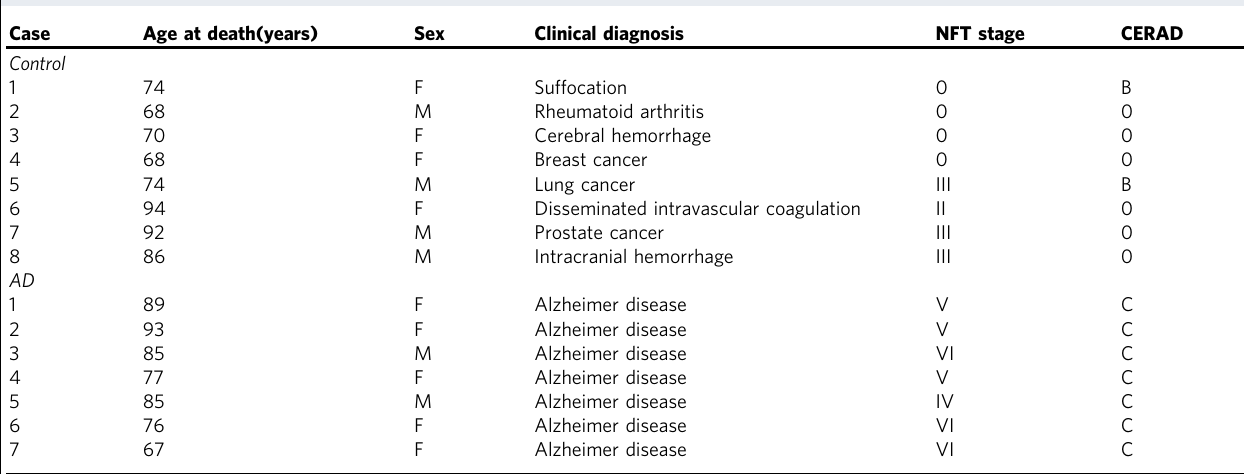
Table 1 Characteristics of human brain